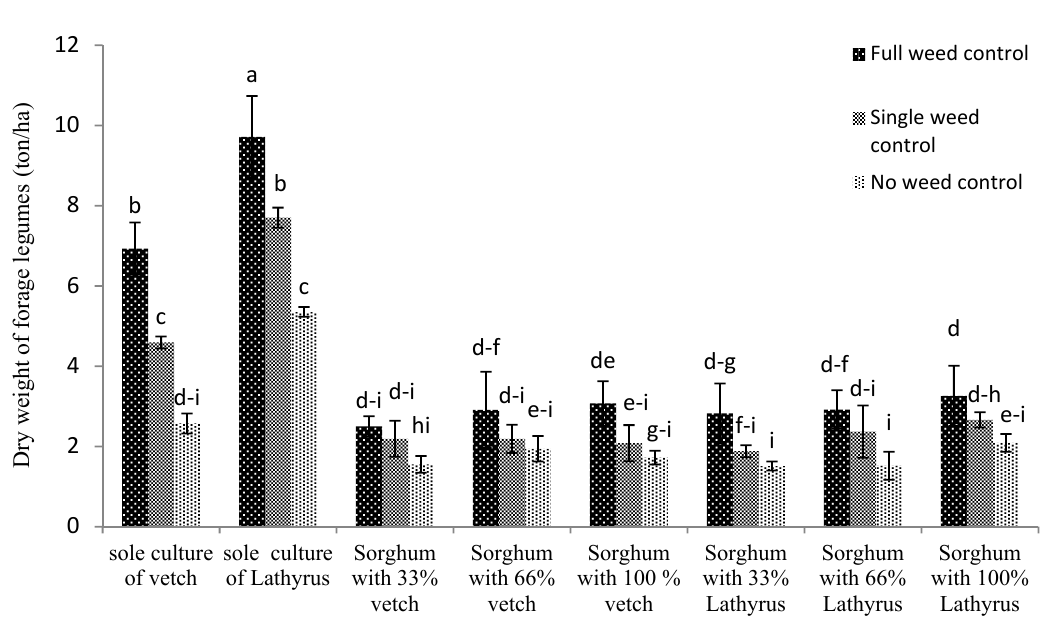
Figure 4. Means ± standard error for the interaction effect of planting density and weed management on dry weight of forage legumes. Different letters on the top of the bars indicate significant difference at p ≤ 0.05 by DMRT.